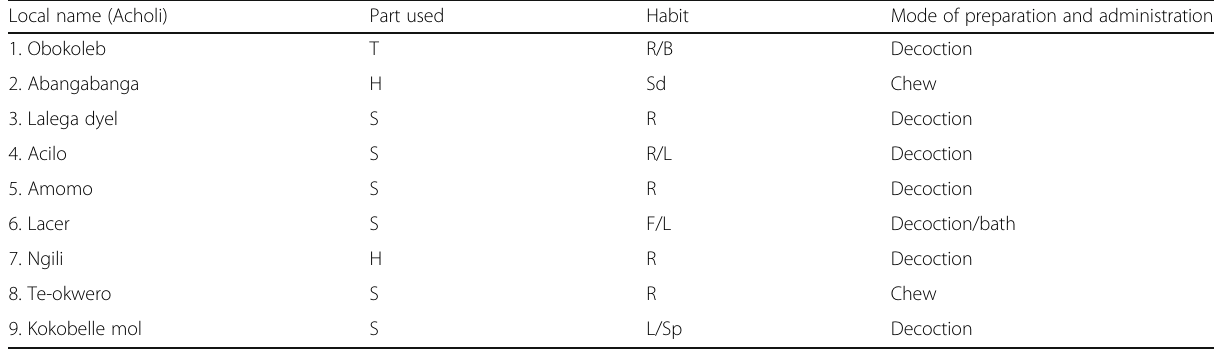
Table 3 Unidentified plant species used for snakebite treatment